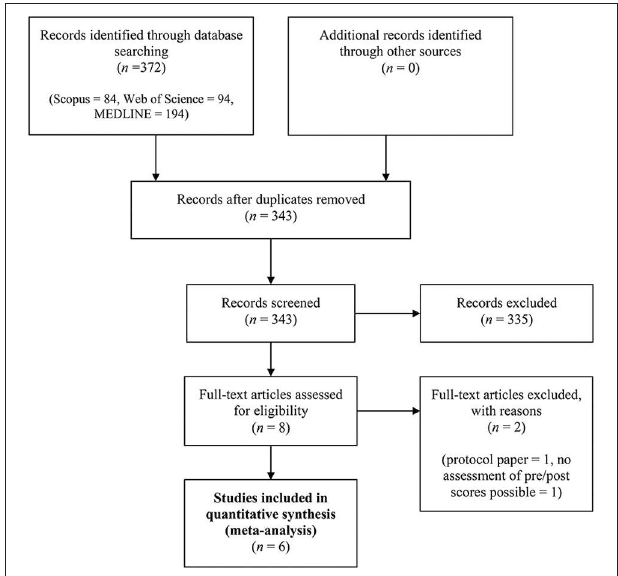
FIGURE 1 | PRISMA flowchart of screening, exclusion, and inclusion criteria.